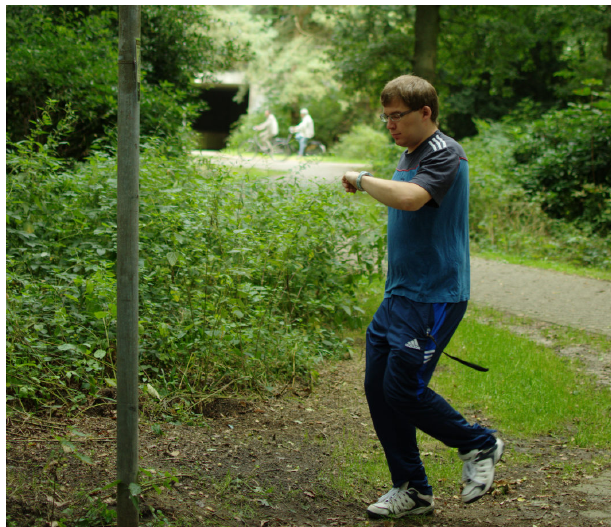
Figure 1. Whilerunning, the user of a visualheart rate display mustshift attentionaway fromthe actual activityto monitorthe heart